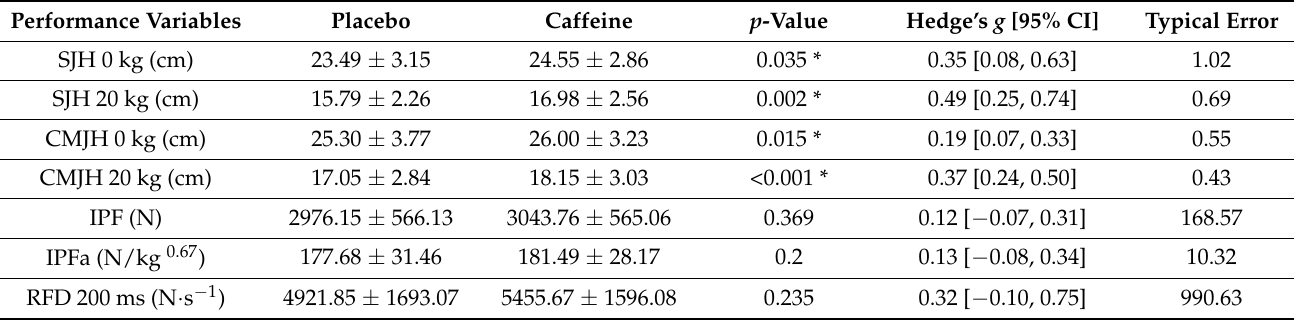
Table 3. The effects of caffeine on performance